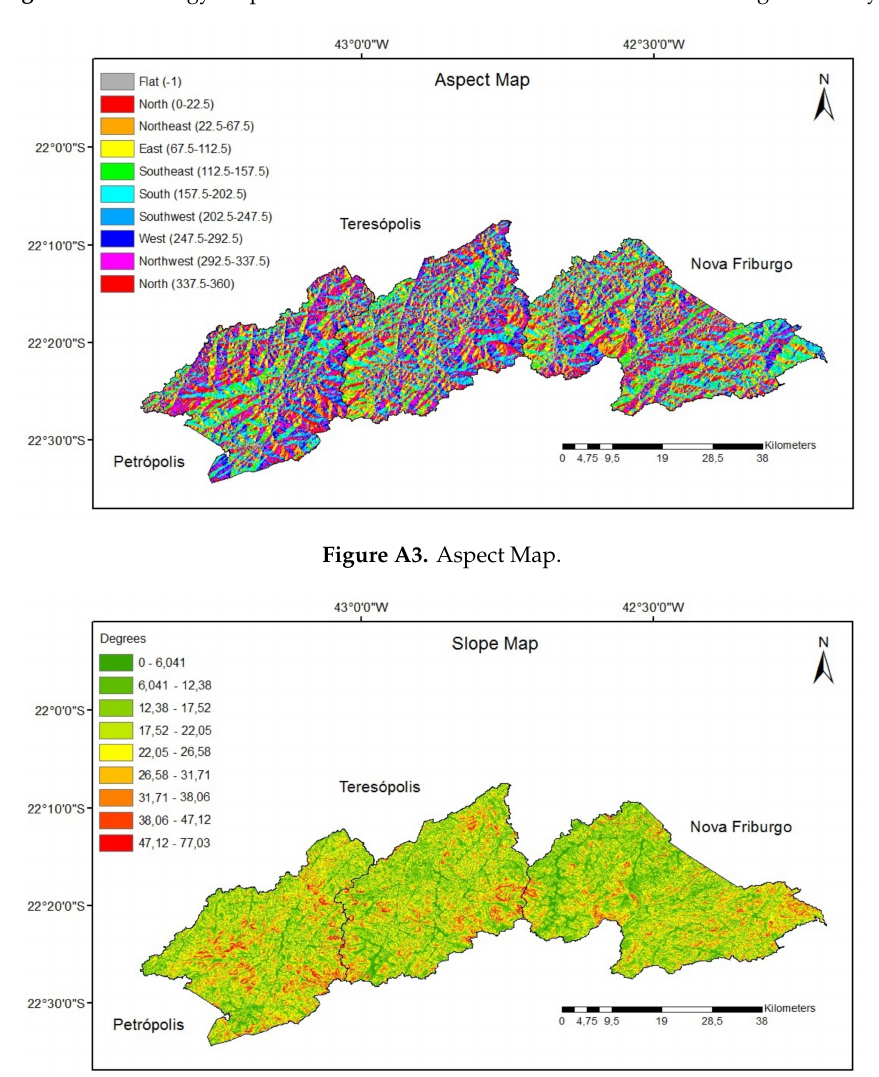
Figure A2. Lithology Map. Scale 1:100.000. Source: CPRM—Brazilian Geological Survey.